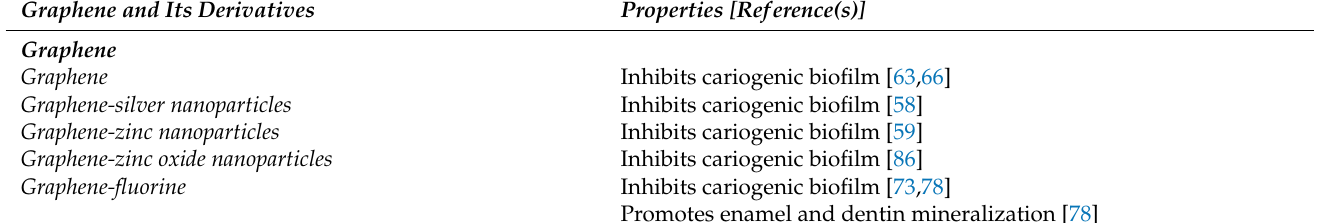
Table 1. The properties of graphene and its derivatives for the management of dental